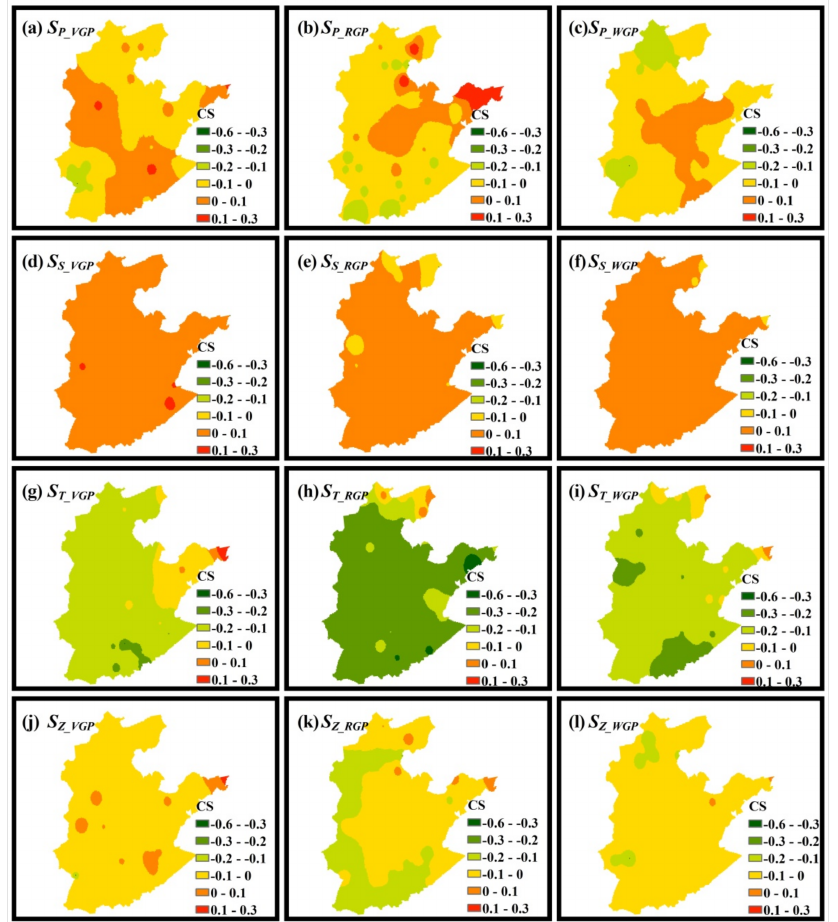
Figure 5. The spatial distribution of the change of maize climate suitability for the vegetative growth period ( a , d , g , j ), reproductive growth period ( b , e , h , k ) and whole growth period ( c , f , i , l ) under SSP585 during the 2040s compared to the baseline period (1981–2010) in the North China